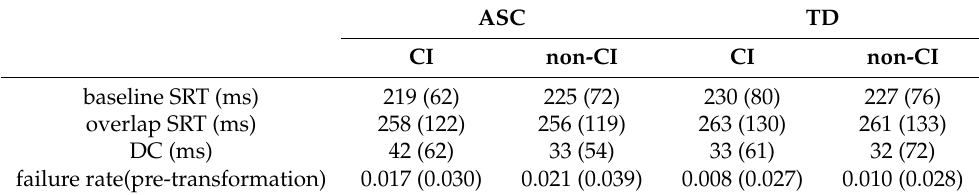
Table 4. The means and standard deviation of all measures in Experiment